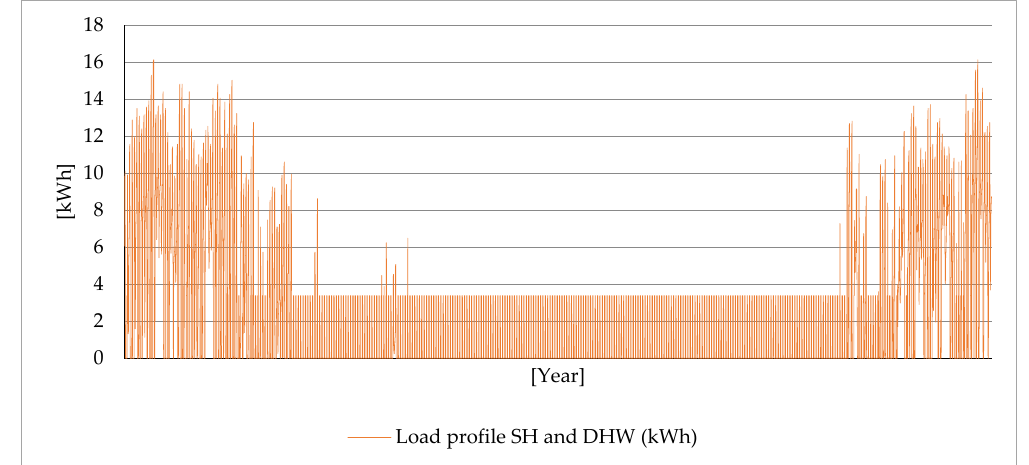
Figure 2. Space heating SH) and domestic hot water ( DHW) energy demand.